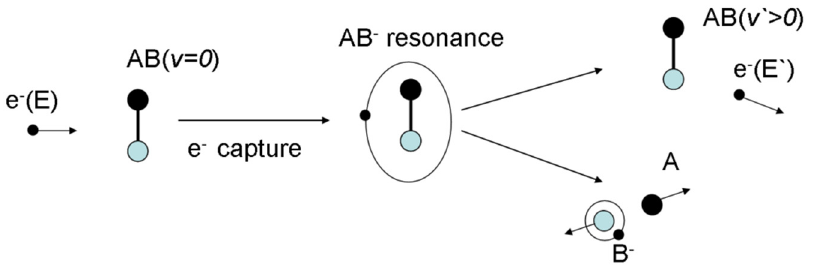
Figure 3. Diagram of dissociative electron attachment in a resonant electron molecule.